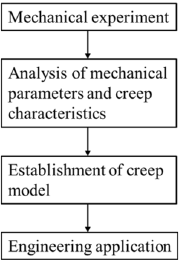
Figure 1. Flowchart of study.